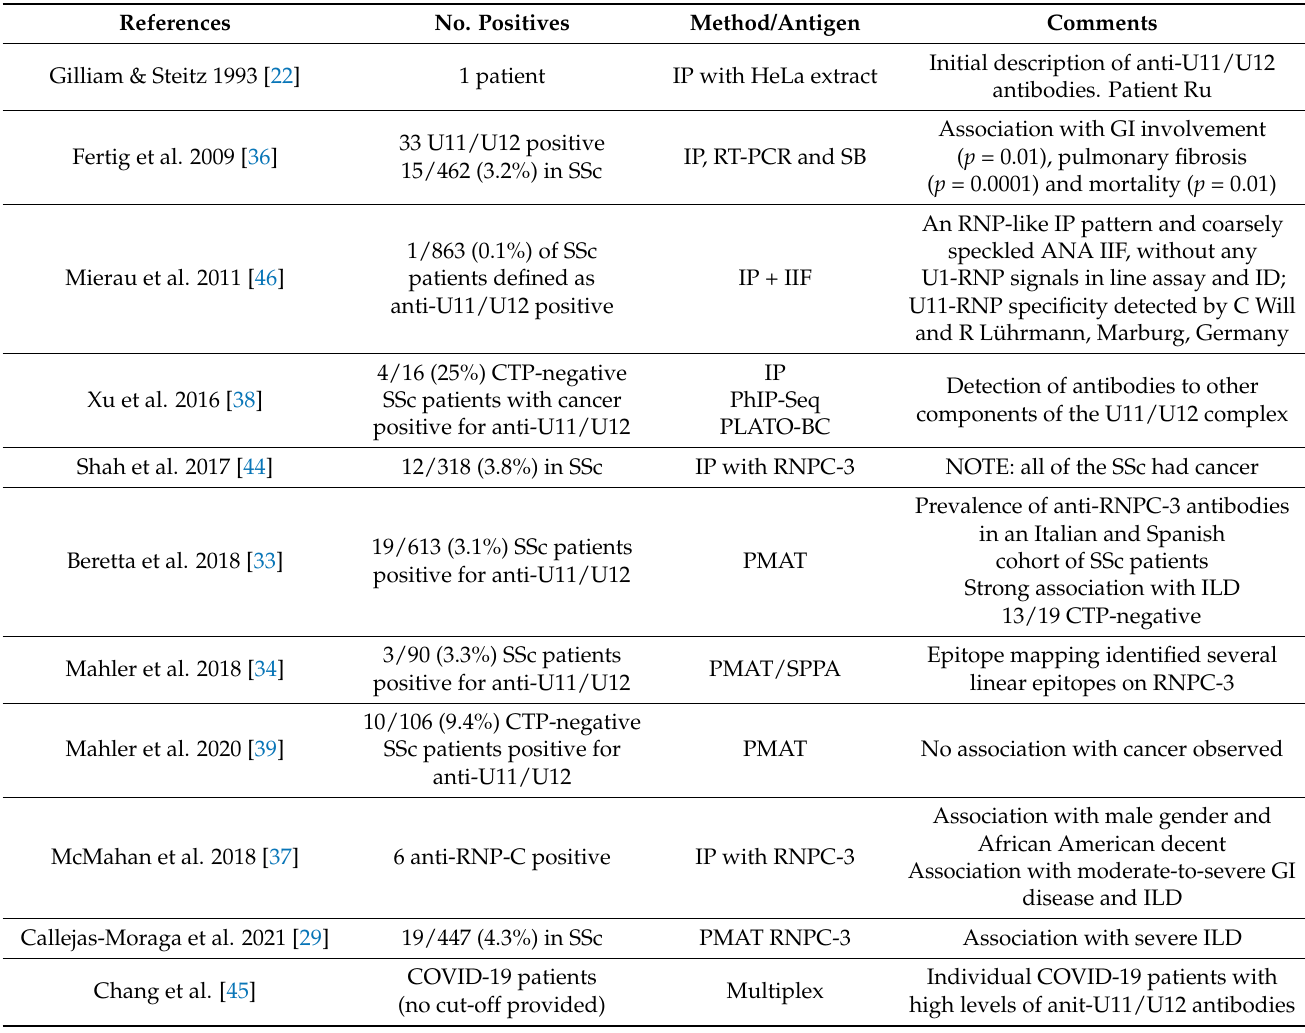
Table 2. Overview of studies on anti-U11/U12